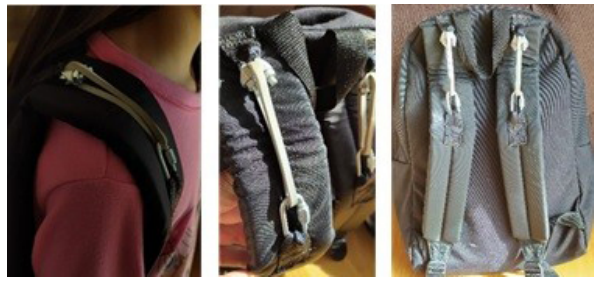
Fig. 1. The modified tested backpack